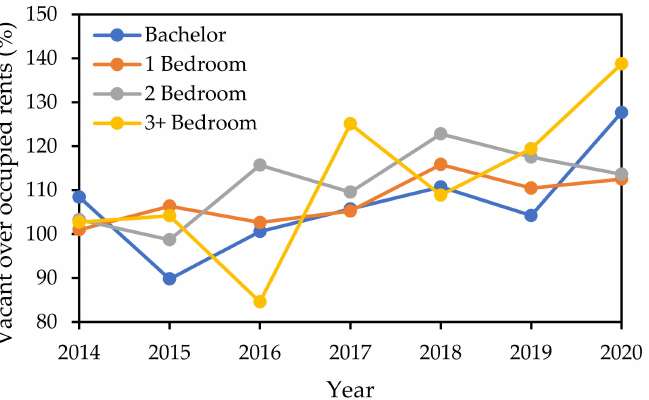
Figure 3. Premium of vacant rents over occupied rents by year in the Kitchener–Waterloo–Cambridge CMA [94].